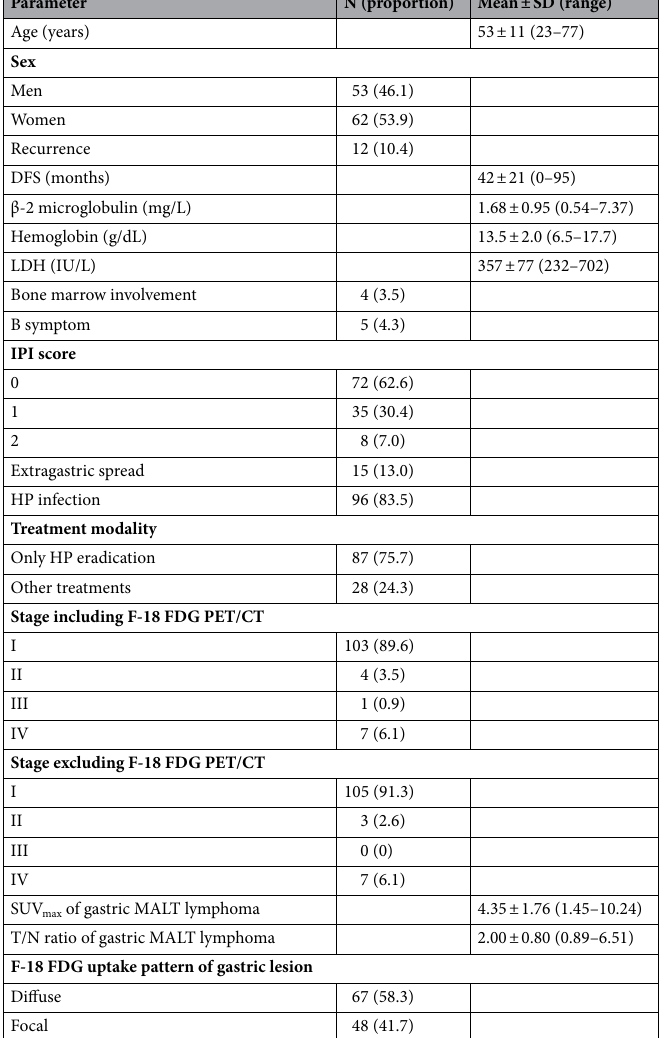
Table 1. Baseline characteristics of 115 patients. SD, standard deviation; DFS, disease free survival; LDH, lactate dehydrogenase; IPI, international prognostic index; HP, helicobacter pylori ; F-18 FDG, fluorine-18- fluorodeoxyglucose; PET, positron emission tomography; CT, computed tomography; SUV max , maximum standardized uptake value; MALT, mucosa-associated lymphoid tissue; T/N ratio, tumor-to-normal tissue